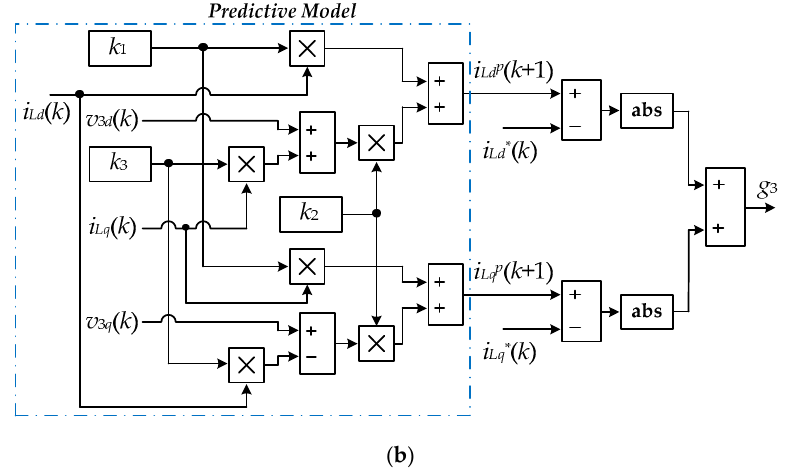
Figure 3. Block diagram representing modeling of a cost function for the FS-MPC in ( a ) αβ -frame and, ( b ) dq -frame using a voltage vector v 3 .